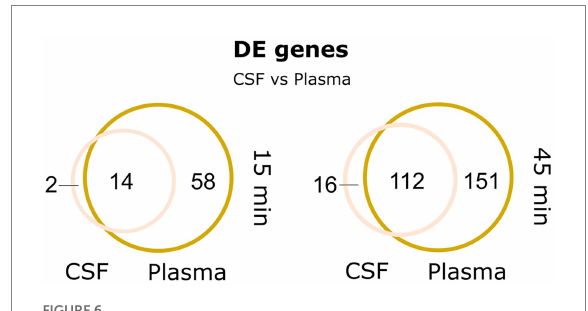
FIGURE 6 Venn-diagrams depicting the large overlap in differentially expressed genes between plasma and CSF at 15 and 45